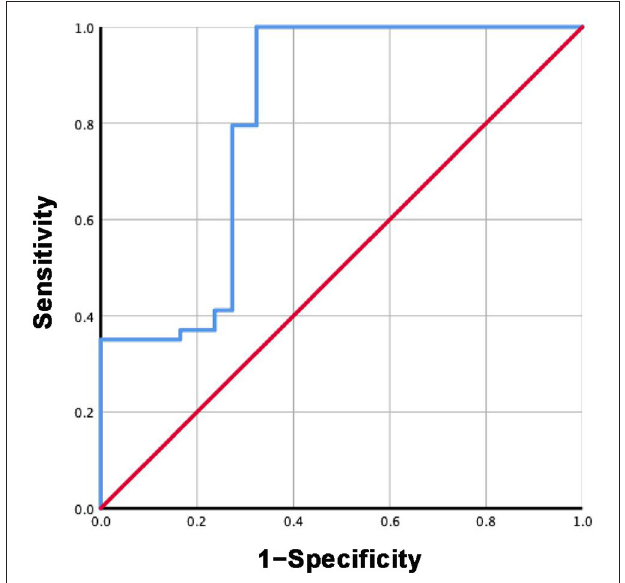
FIGURE 7 | ROC curve of sST2 levels between HF and healthy groups.